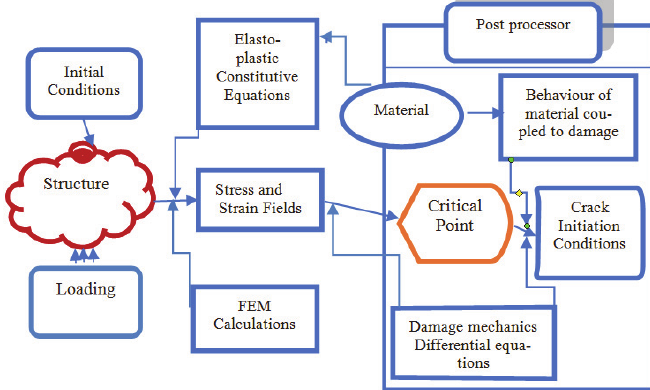
Figure 1: Locally coupled analysis of crack